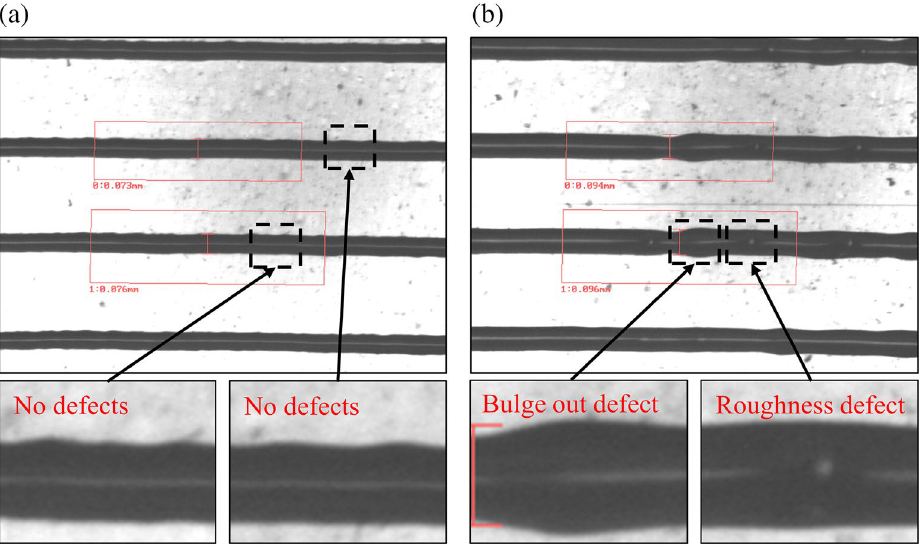
Figure 3. Images of printed lines captured by the camera: ( a ) printed lines without defects, ( b ) with